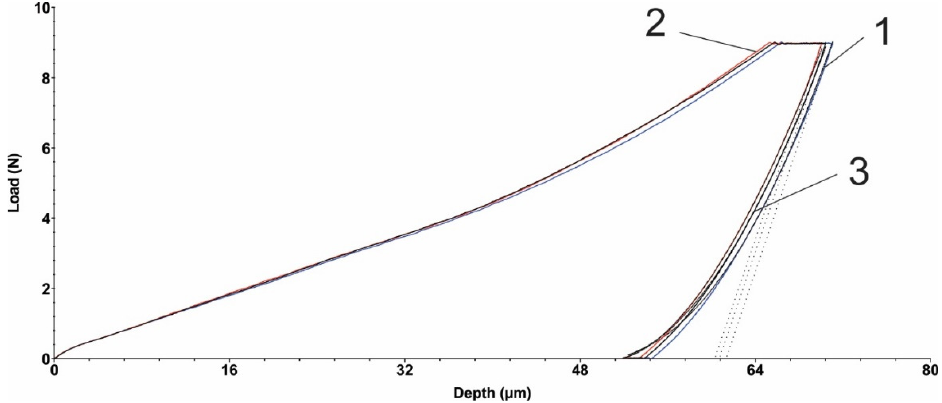
Figure 7. Square texture microindentation test (2 passes): 1, 2, 3—measurements.